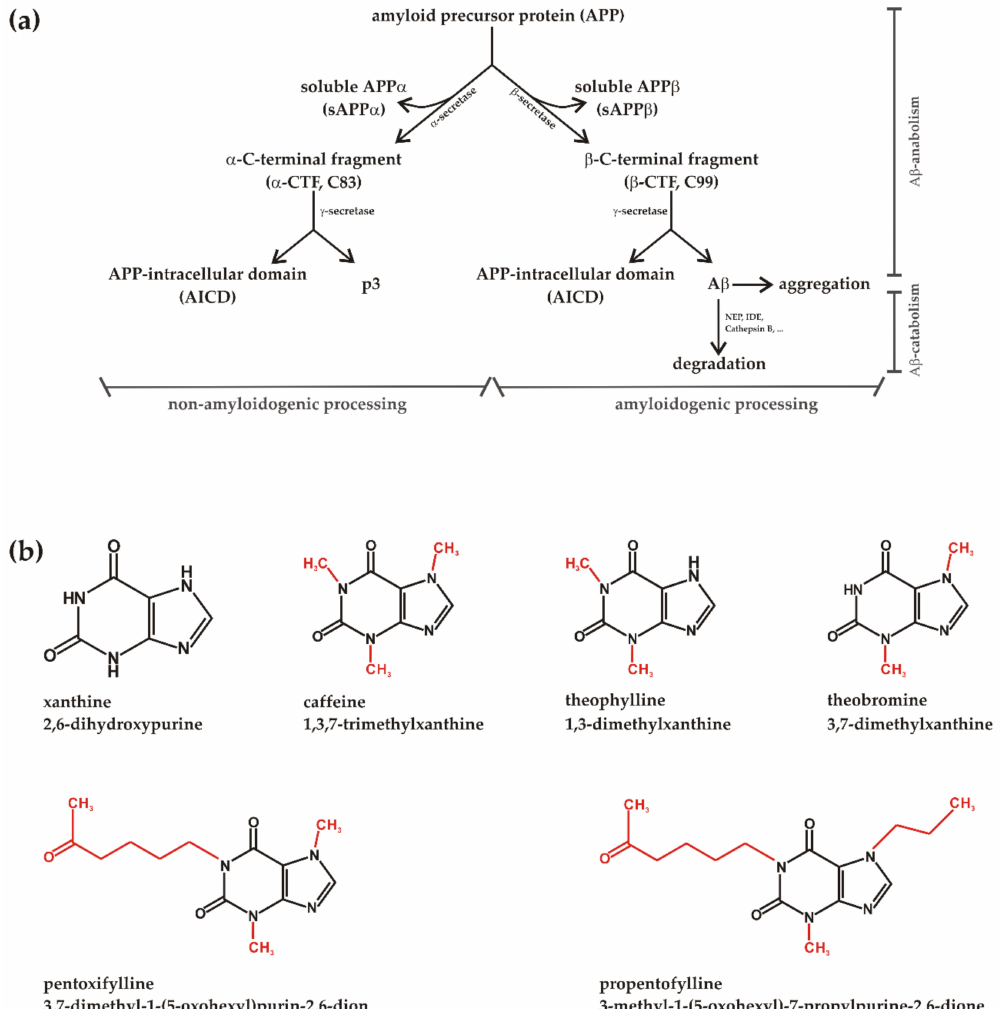
Figure 1. ( a ) Model of non-amyloidogenic and amyloidogenic processing of the amyloid precursor protein (APP) with subdivision into anabolism and catabolism of the neurotoxic APP cleavage product A β . The involved secretases and the resulting products are illustrated. ( b ) Chemical structures of xanthine (2,6-dihydroxypurine) and the analyzed methylxanthines (MTXs) ca ff eine (1,3,7-trimethylxanthine), theophylline (1,3-dimethylxanthine), theobromine (3,7-dimethylxanthine), pentoxifylline (3,7-dimethyl-1-(5-oxohexyl)purin-2,6-dion) and propentofylline (3-methyl-1-(5-oxohexyl)-7-propylpurine-2,6-dione). In red color the structural di ff erences between the MTXs are